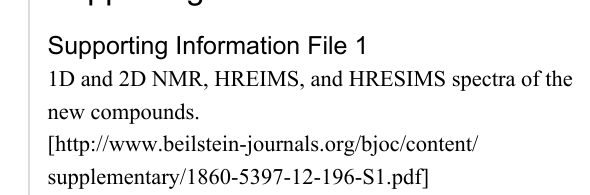
X-ray crystallographic analysis. Single crystal X-ray diffrac- tion data were collected at 123 K on an Agilent Gemini Ultra diffractometer with CuK α radiation ( λ = 1.54178 Å). The struc- tures were solved by direct methods (SHELXS-97) and refined using full-matrix least-squares difference Fourier techniques. Hydrogen atoms bonded to carbons were placed on the geomet- rically ideal positions by the “ride on” method. Hydrogen atoms bonded to oxygen were located by the difference Fourier method and were included in the calculation of structure factors with isotropic temperature factors. Crystallographic data for 2 , 7 and 8 have been deposited with the Cambridge Crystallo- graphic Data Centre. Copies of the data can be obtained, free of charge, on application to the Director, CCDC, 12 Union